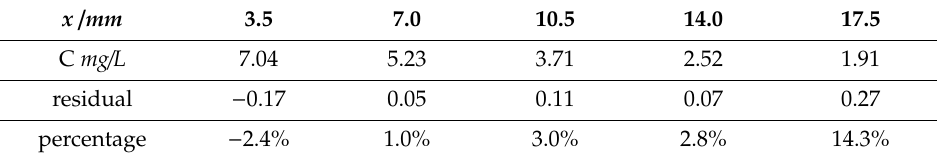
Table 3. Residual at third day of inward diffusion.